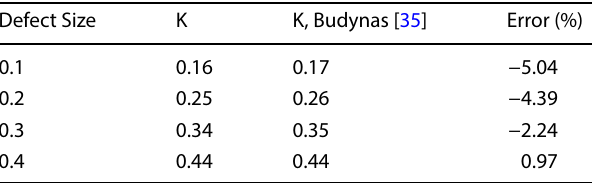
Table 6 2× LR stress intensity factors and errors for pressure vessel configuration 1